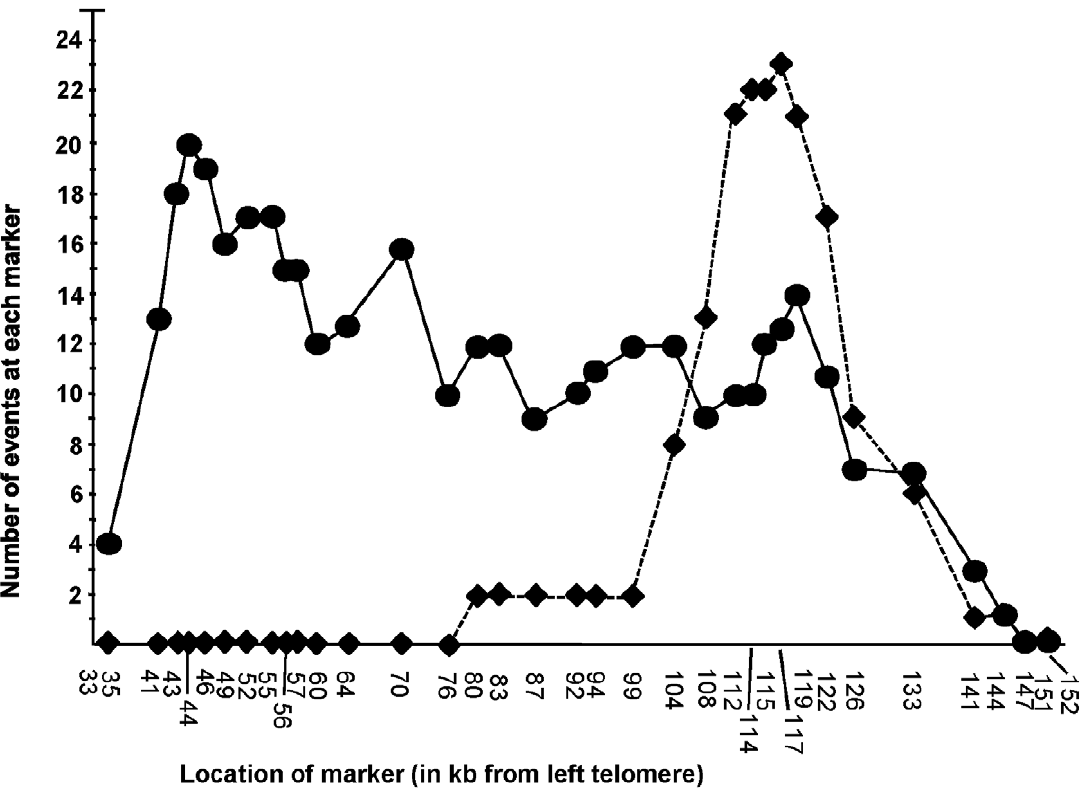
Figure 5. Comparison of the distribution of mitotic gene conversion events in PSL100/PSL101 (lacking the (GAA) n tract) and WXTMD46 (containing the (GAA) 230 tract). For each heterozygous marker, we show the number of events that include that marker in PSL100/ PSL101 (circles connected by undotted lines) and WXTMD46 (diamonds connected by dotted lines). The conversion events in PSL100/PSL101 occurred throughout the 120 kb interval with an elevation of events near markers 43 and 44, and a reduction in conversion near the centromere. In WXTMD46, the events are strongly biased toward the position of the GAA tract between markers 115 and 117.